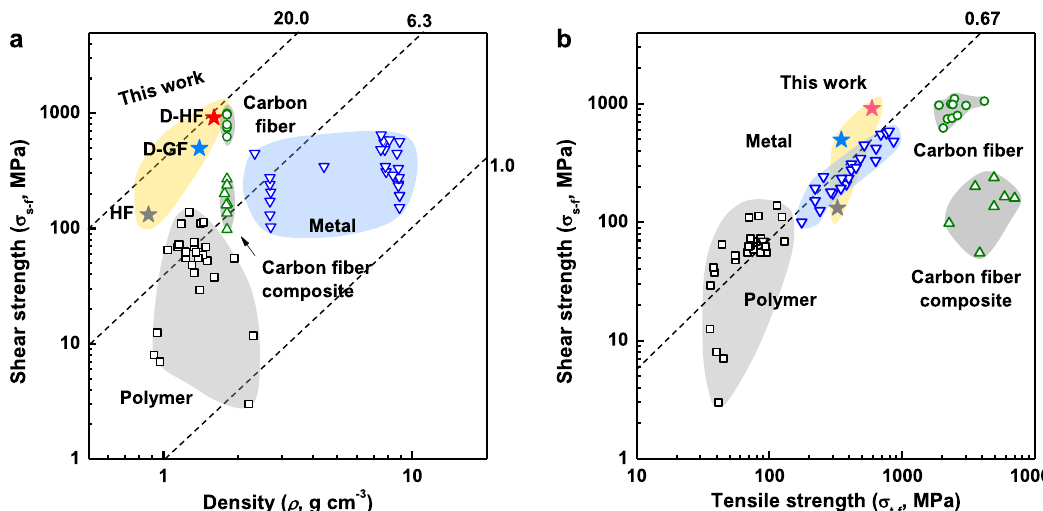
Fig. 4 Comparison of mechanical strengths of the fi bers. a Ashby plot of the shear failure strength ( σ s-f ) and density ( ρ ). The dotted lines denote the material indices for minimum mass design with limited strength corresponding to σ 1/2 / ρ values of 1.0 to 20.0 in units of MPa 1/2 /(g cm − 3 ). They provide the slope of the family of parallel lines belonging to that index. All of the materials that lie on the same line perform equally well as a light, torsional shaft where those above the line perform better and those below perform worse. b Ashby plot of the shear and tensile strengths. The dotted line denotes the relationship between the shear strength and tensile strength based on the distortion-energy theory, machinery handbook, and Joerres ’ s modi fi ed Goodman